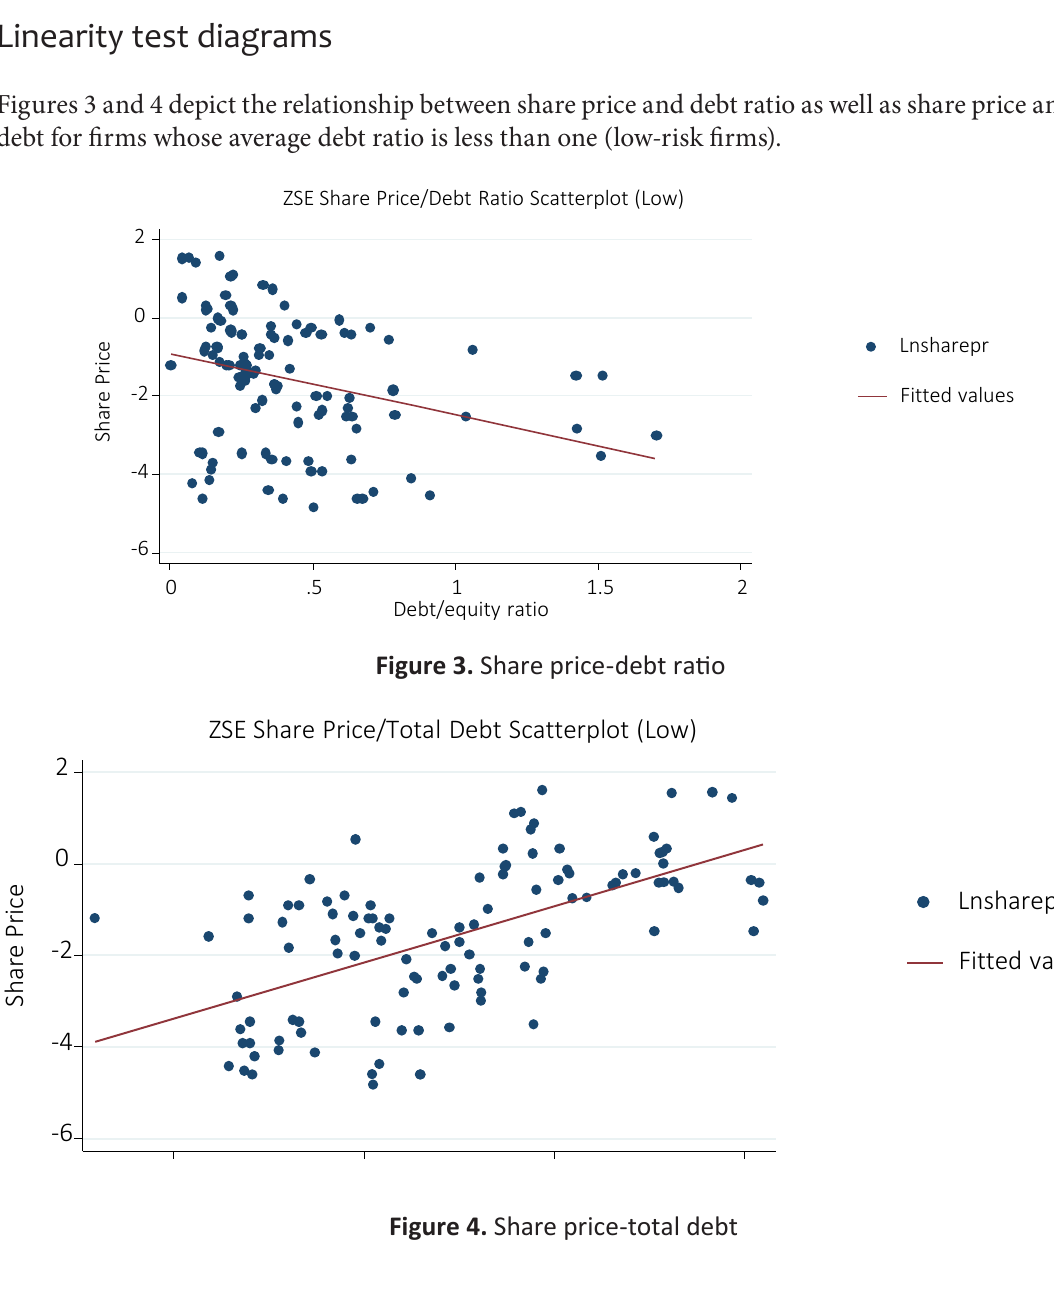
Figure 2. Low-risk firms